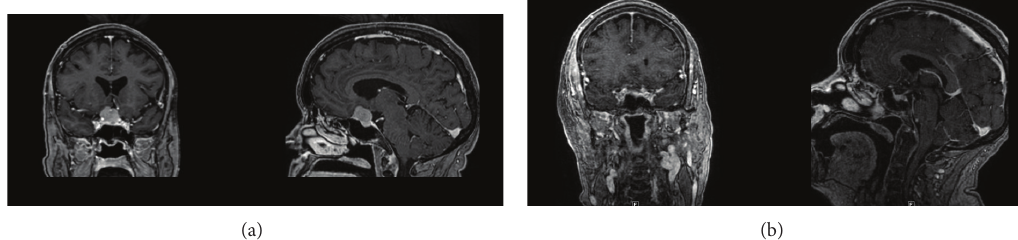
Figure 1: (a) Preoperative and (b) postoperative MR images of a homogeneously enhancing mass involving the tuberculum sellae and planum sphenoidale. Pathology was meningioma. Gross total resection was achieved.